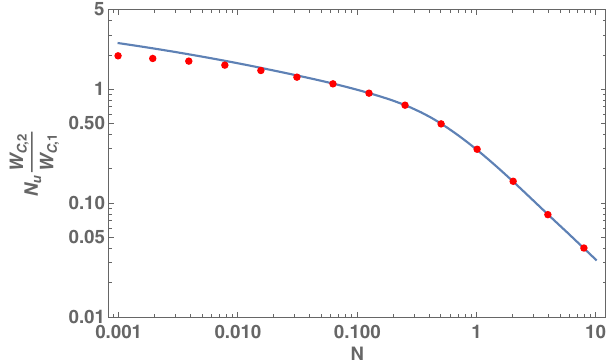
FIG. 8. Top: Ratio of radiated OAM energy at second harmonic to the fundamental in afterburner setup from Eq. (34). Beams =cL with smaller N ¼ ωσ 2 are favorable to produce more OAM x u energy. Here K 1 > 1 is assumed. Dots are from numerical integration of Eq. (28) using the full expression for the field in Eq. (5).FIG. 6. Functions